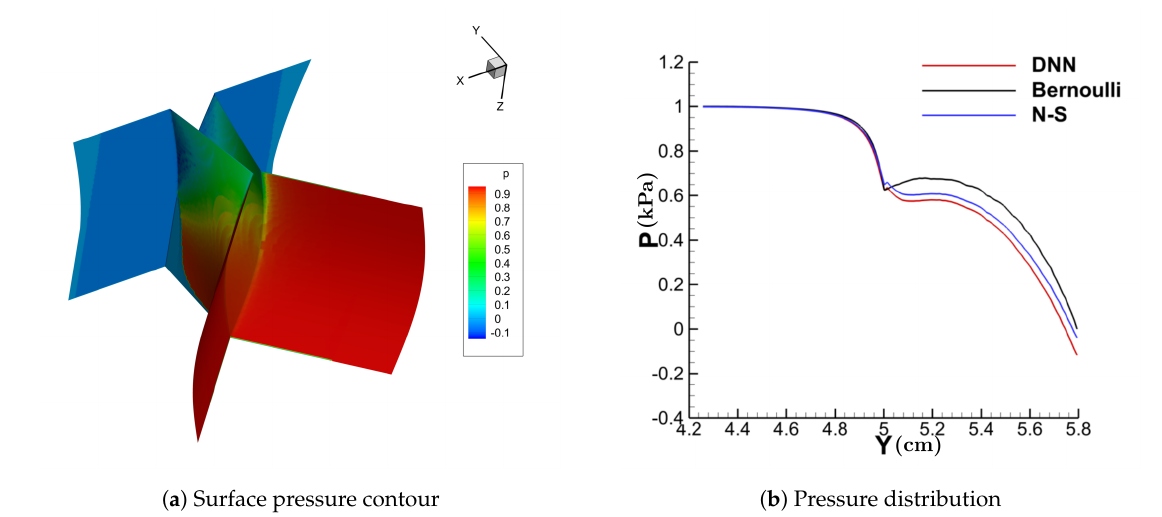
Figure 14. Surface pressure contour and distribution (divergent-convergent).